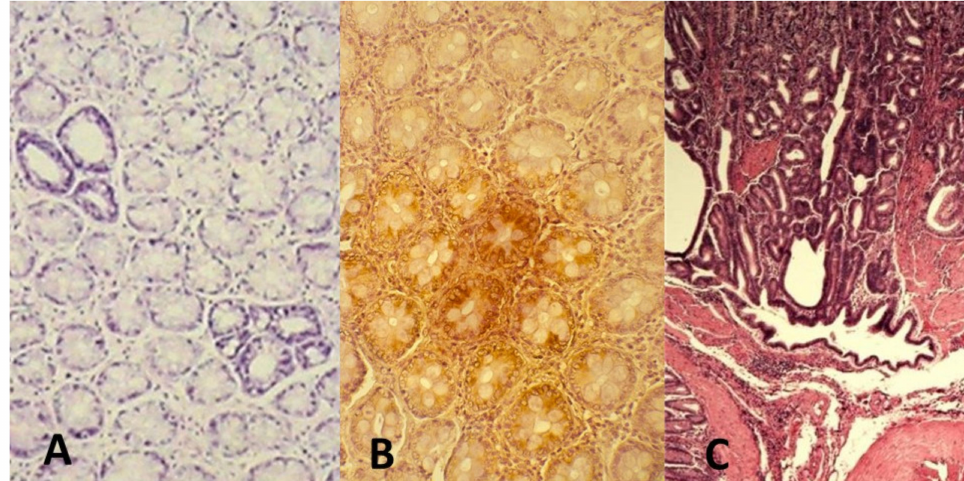
Figure 1. AOM-induced CRC in rat. AOM is an azide compound, active derivative of DMH and induces genetic damage in the colon cells. The carcinogen promotes classical colon carcinogenesis events with adenomas to carcinoma progres- sion [56]. ( A ) aberrant crypts with ( B ) overexpression of p21 k-ras protein (dark brown) and ( C ) development of infiltrating adenocarcinoma after 32 weeks from the induction (original microphotographs from Luca Vannucci’s Lab